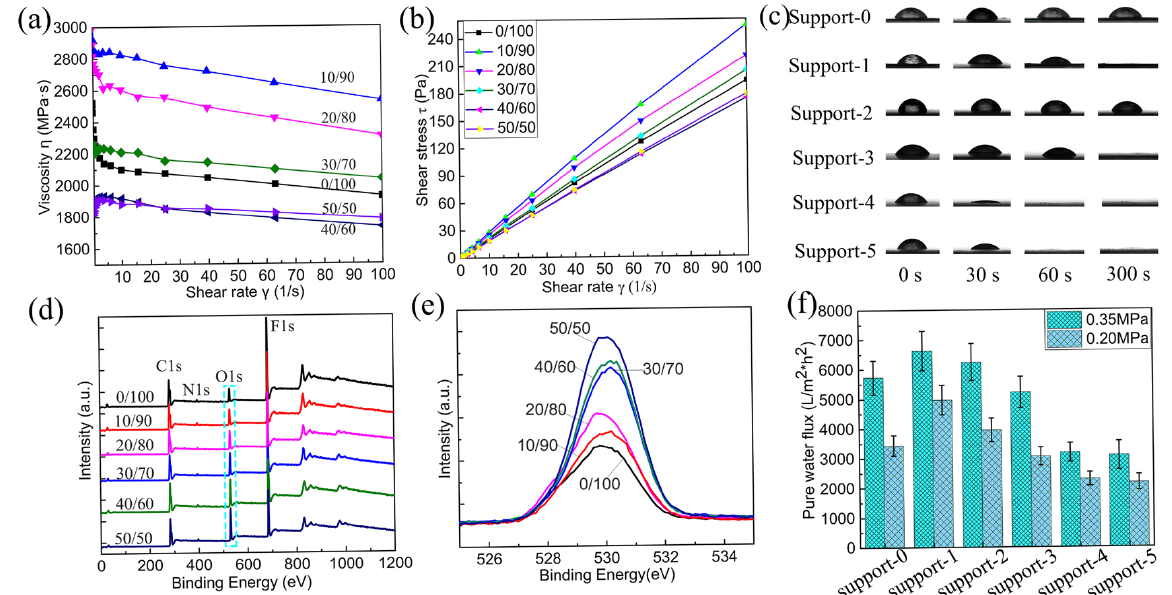
Figure 3. ( a , b ) The rheological properties of different dope solutions; ( c ) dynamic water contact angle of different supports; ( d ) XPS spectra of the different supports surfaces; ( e ) the O element spectra of different supports surfaces; ( f ) pure water flux of different supports.